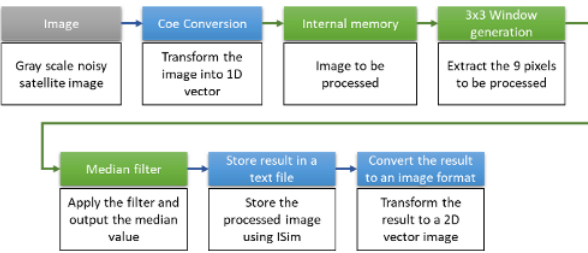
Fig. 4. Simulation architecture.